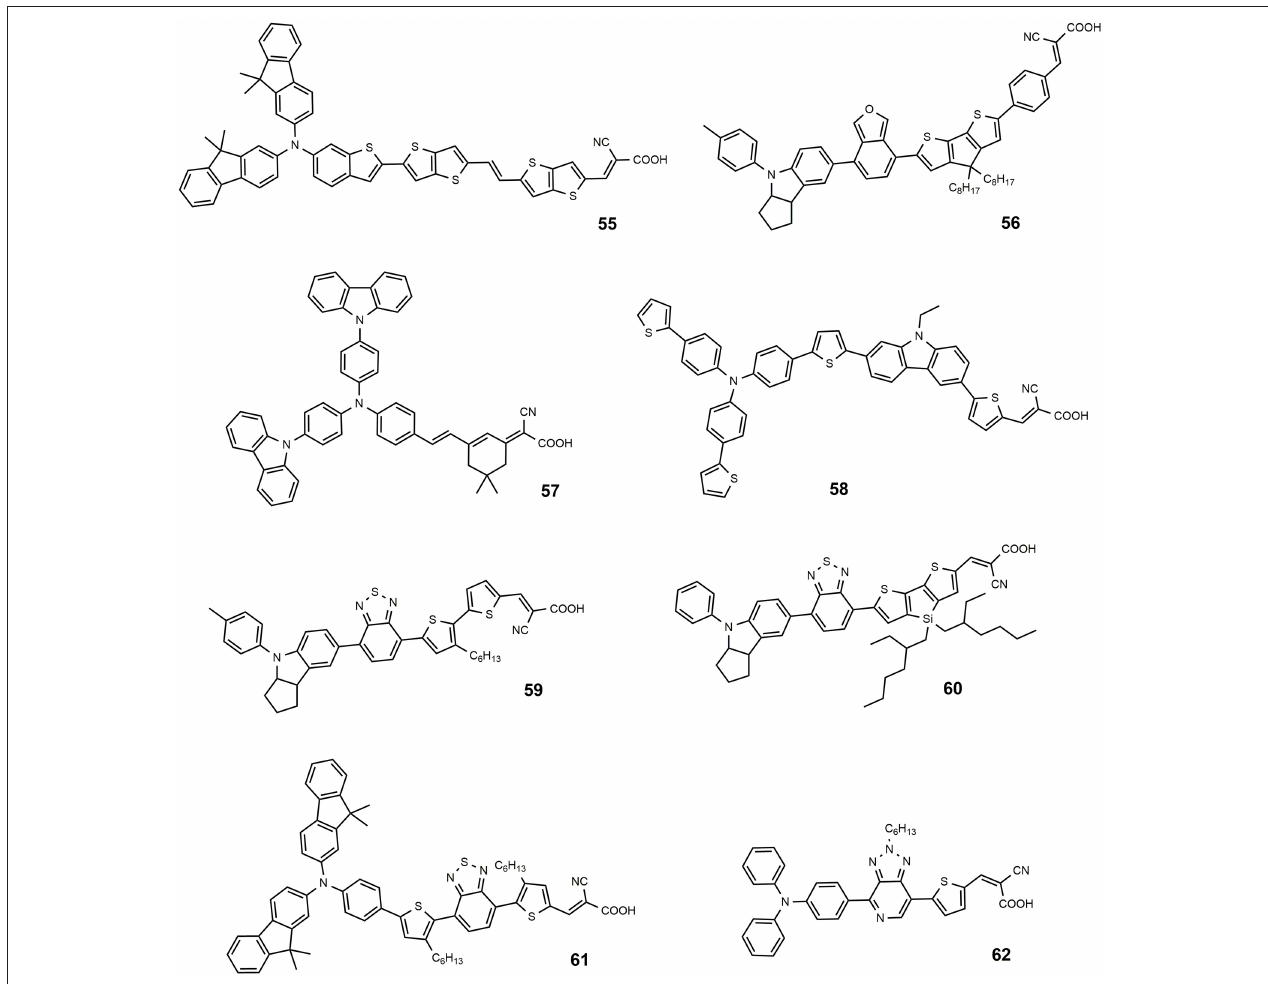
FIGURE 8 | Chemical structures of dyes